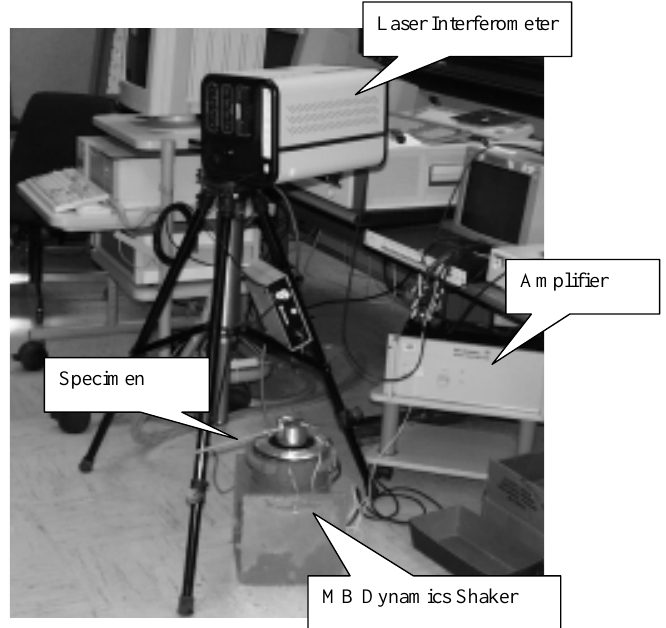
Fig. 3. Uniaxial test